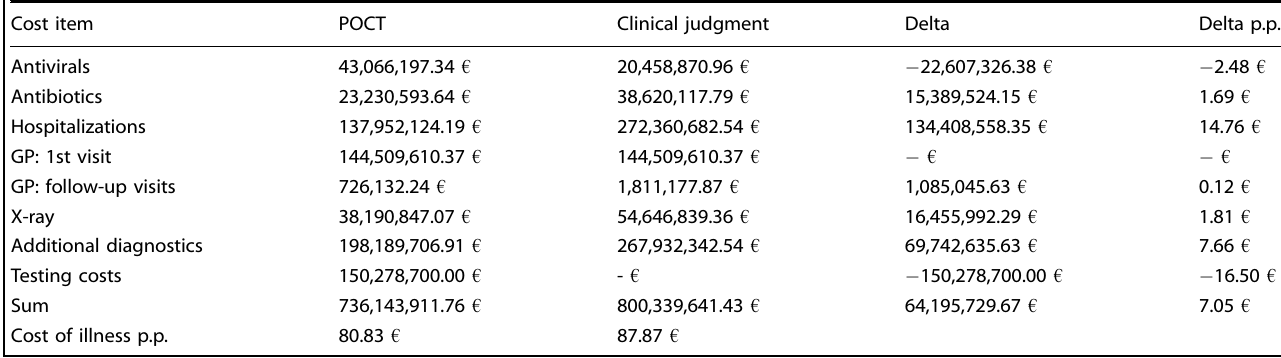
Table 4. Calculation